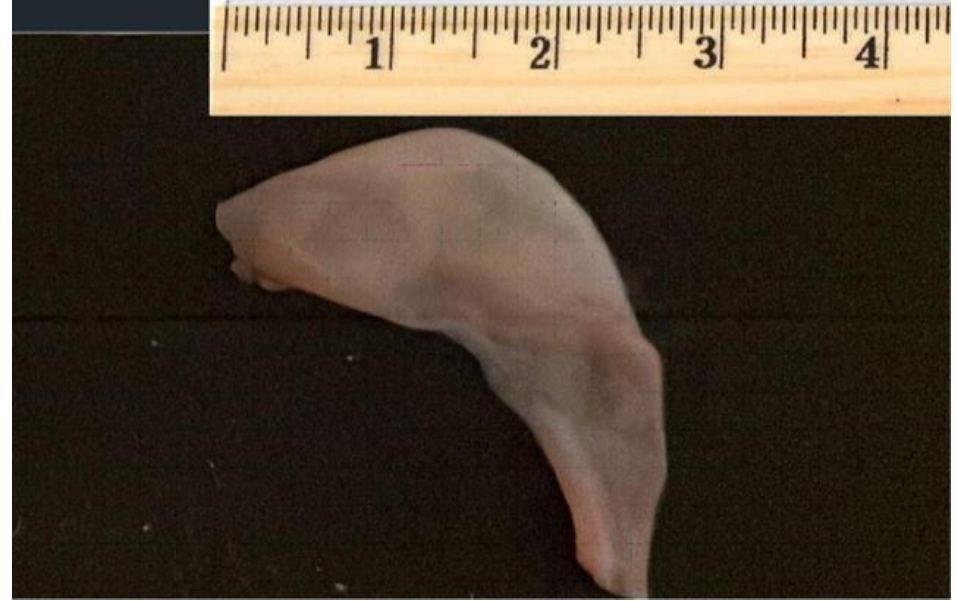
Figure 2. Membrane